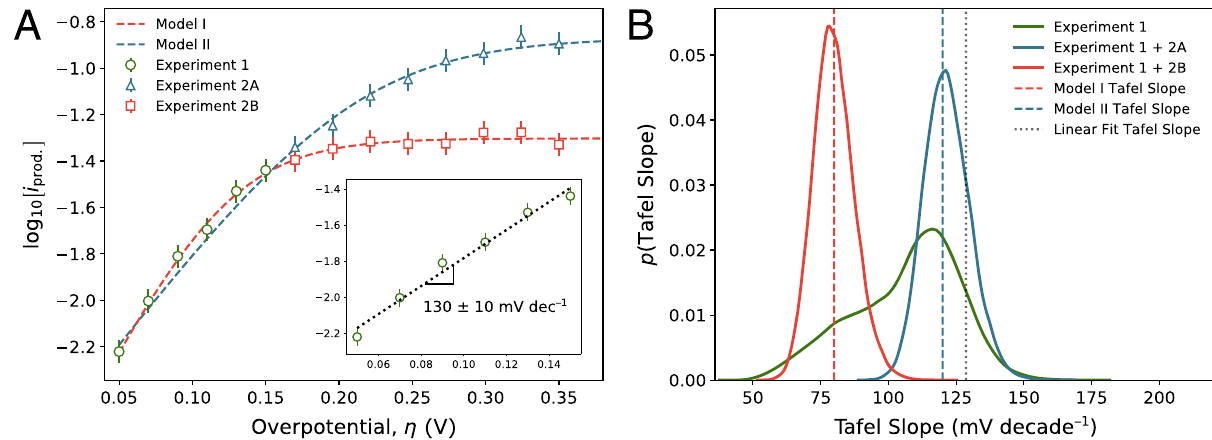
Fig. 2 Bimodal posterior distributions signify Tafel slope ambiguity that cannot be clari fi ed by the available data. A (inset) Synthetic current – voltage data collected in hypothetical Experiment 1 appears linear over a 100 mV overpotential region, with a Tafel slope of 130 ± 10 mV/decade. A Synthetic current – voltage data over a broader range of overpotentials. The dashed lines show two models (I, II) with different Tafel slopes and plateau currents that could both reasonably fi t the Experiment 1 data. Synthetic error bars represent one standard error of the mean of uncertainty in the synthetic data. Experiment 2A (blue triangles) and 2B (red squares) represent two possible outcomes of experiments that probe a broader range of overpotentials, which can clearly distinguish between Model I and Model II. B Bayes posterior distributions over the Tafel slope determined by our algorithm given various sets of observed data. If the algorithm is fed just the Experiment 1 data, the posterior distribution over the Tafel slope is broad and weakly bimodal, indicating that the Experiment 1 data is insuf fi cient to discriminate between Model I and Model II. When fi t to the Experiment 2A or 2B data in addition to the Experiment 1 data, this bimodality splits cleanly into two separate modes centered at the Model I and Model II Tafel slopes. Note that the Tafel slope extracted from a linear fi t to just the Experiment 1 data is distinct from both the Model I and Model II Tafel